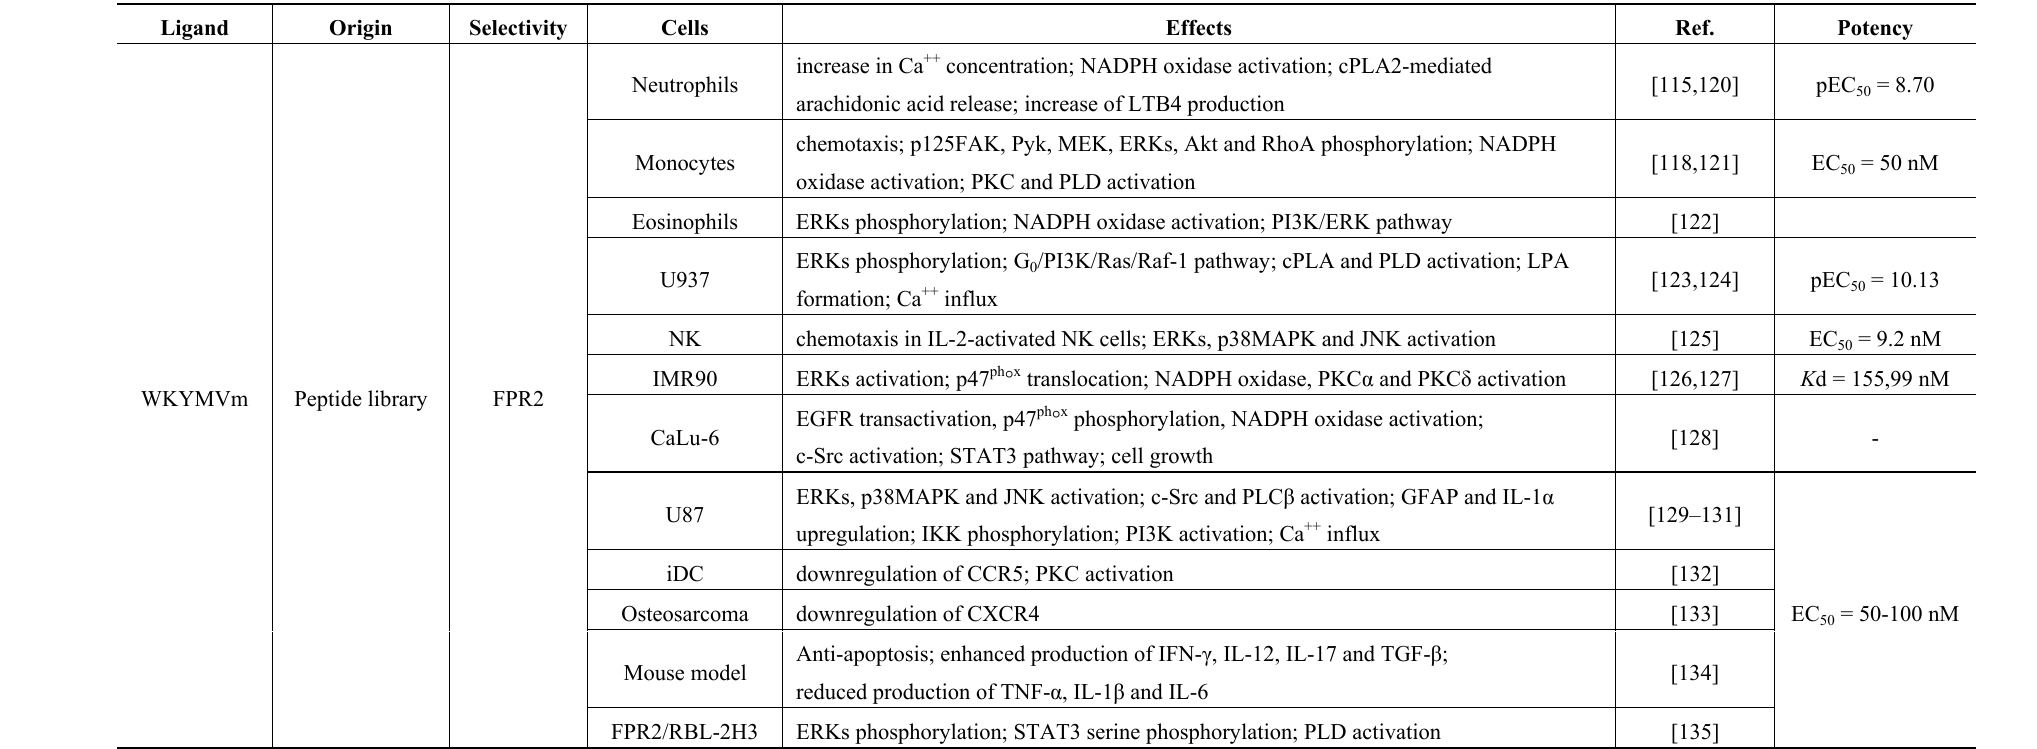
Table 8. Intracellular signaling cascades triggered by